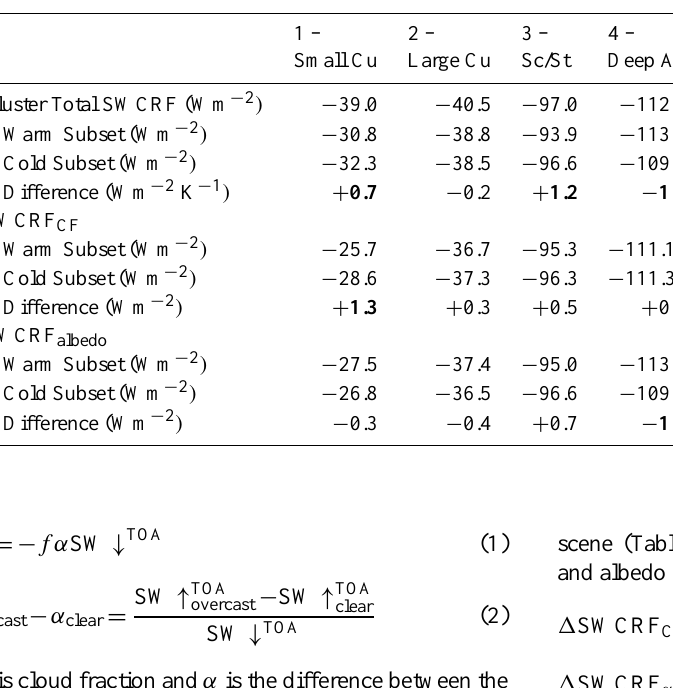
Table 5. Average total SWCRF, SWCRF from cloud fraction change, and SWCRF from albedo change for entire the cluster, warm subset, cold subset, and the difference between the two (per degree temperature change; Subsets different at the 95% confidence level are in